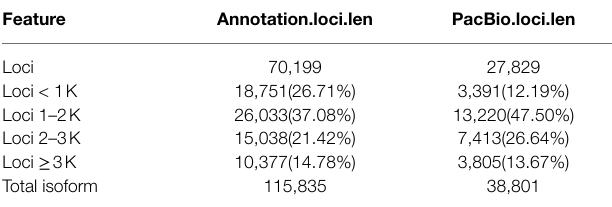
TABLE 2 | Gene structure